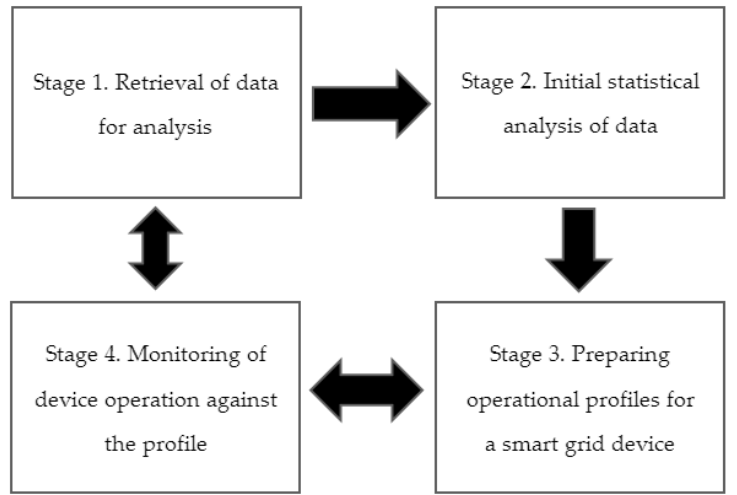
Figure 5. Simplified illustration of the system operation.